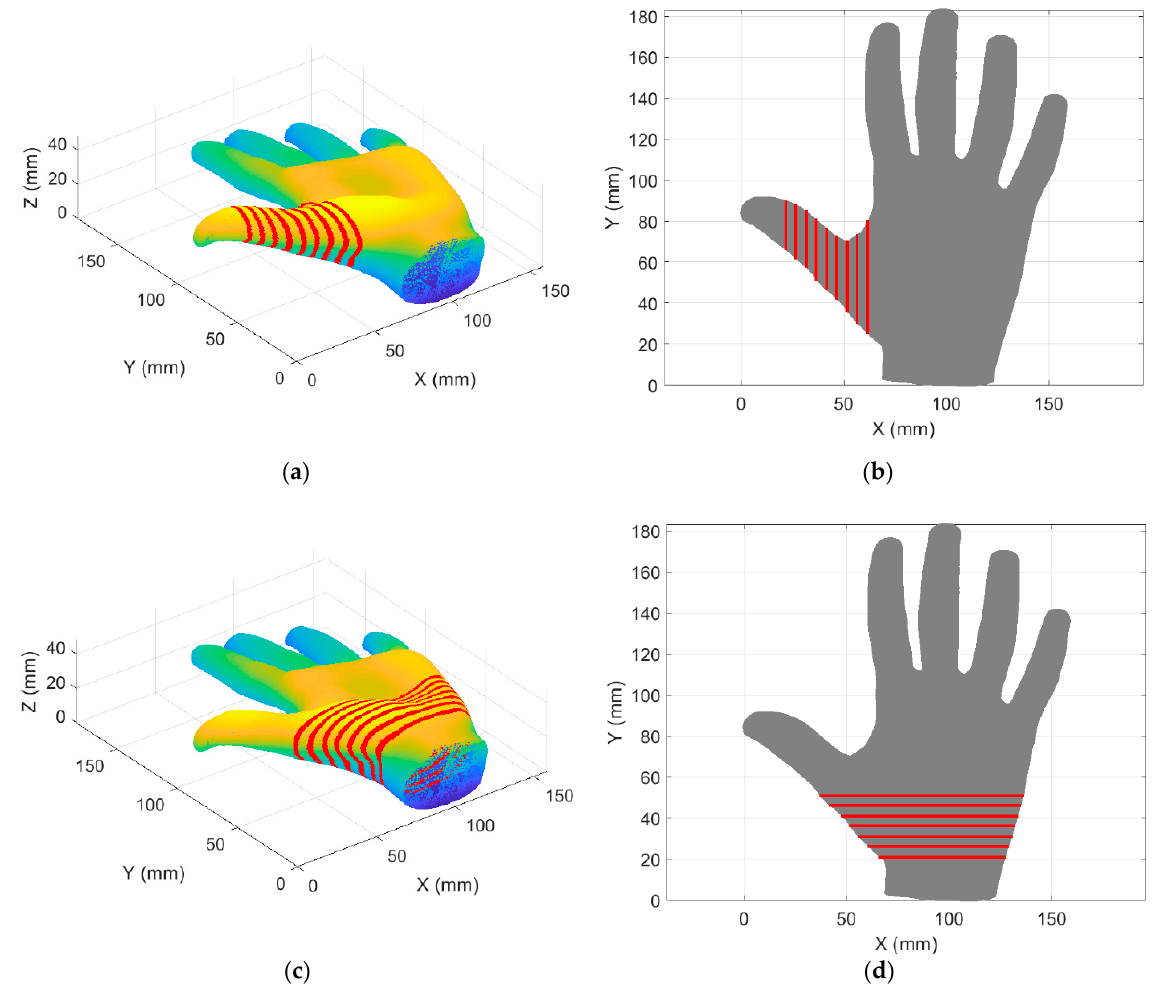
Figure 8. Cross section (red circles) generated for Zone 1 and Zone 2: ( a ) A 3D view of Zone 1 cross sections; ( b ) A 2D view (XY) of Zone 1 cross sections; ( c ) A 3D view of Zone 2 cross sections; ( d ) A 2D view (XY) of Zone 2 cross sections.